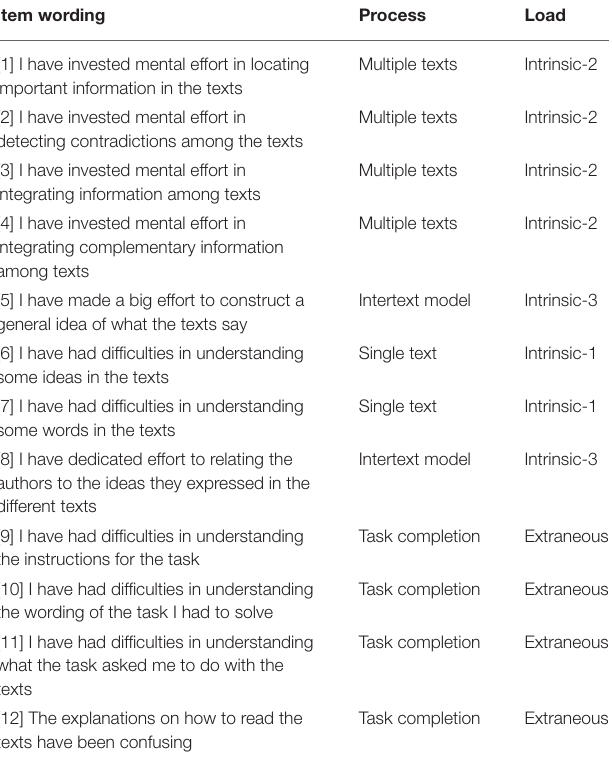
TABLE 1 | Cognitive Load questionnaire for Multiple Documents Reading (CL-MDR), organized by cognitive process and type of cognitive load: items 1–8 represent three subtypes of intrinsic cognitive load, whereas items 9–12 represent extraneous cognitive